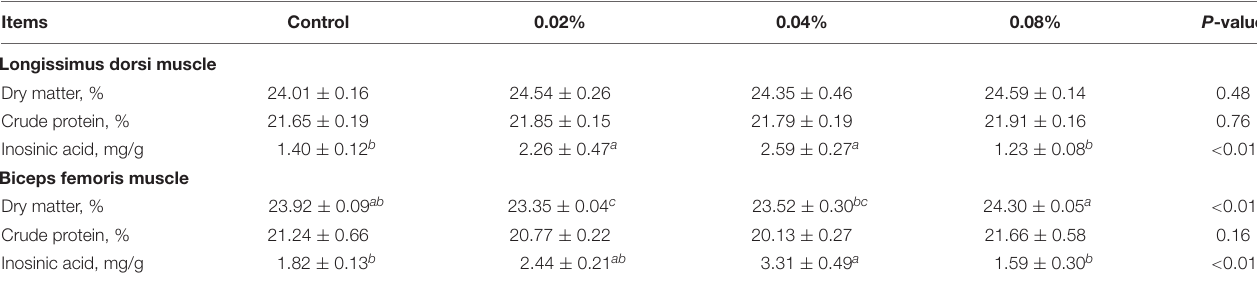
TABLE 5 | Effects of different levels of dietary CGA supplementation on muscle nutritional components of the finishing